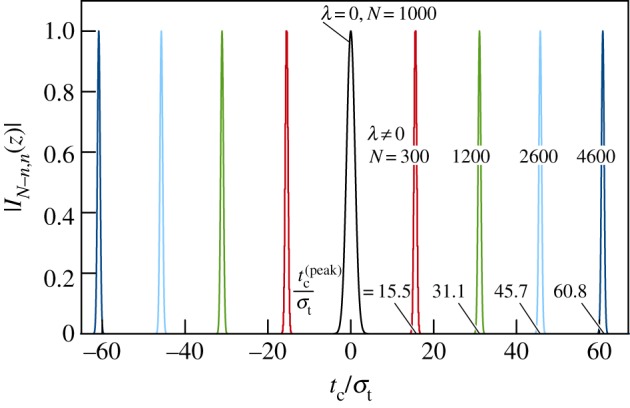
|IN−n,n(z)| as a function of the scaled clock time tc/σt, where tc= (2n−N)δt for different values of λ and N. As in figure 4, the points (|IN−n,n(z)|,tc/σt) are generated parametrically by varying n. For clarity, in each case, straight lines connect consecutive discrete points of |IN−n,n(z)| to form a continuous curve. However, as discussed in the text and illustrated by figure 4, the locus of points representing |IN−n,n(z)| is essentially a continuous curve for N≥N(time)min. The black curve represents the T-invariant case (i.e. λ=0) and has been generated for N=1000. It does not visibly change with increasing values of N. The remaining curves represent the T violation case (i.e. λ≠0) for θ=2.23π and a range of N values as follows: red curve for N=300 and t(peak)c=15.5 σt, green curve for N=1200 and t(peak)c=31.1 σt, light blue curve for N=2600 and t(peak)c=45.7 σt, and dark blue curve for N=4600 and t(peak)c= 60.8 σt. All curves have been scaled to give a maximum of unity.